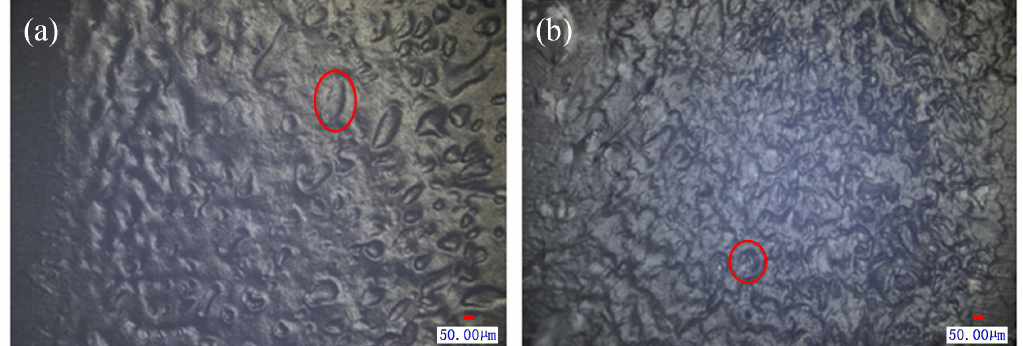
Figure 13. ( a ) The micro morphology of the welding zone between PP and PA66; ( b ) The micro morphology of the welding zone between TGMPP and